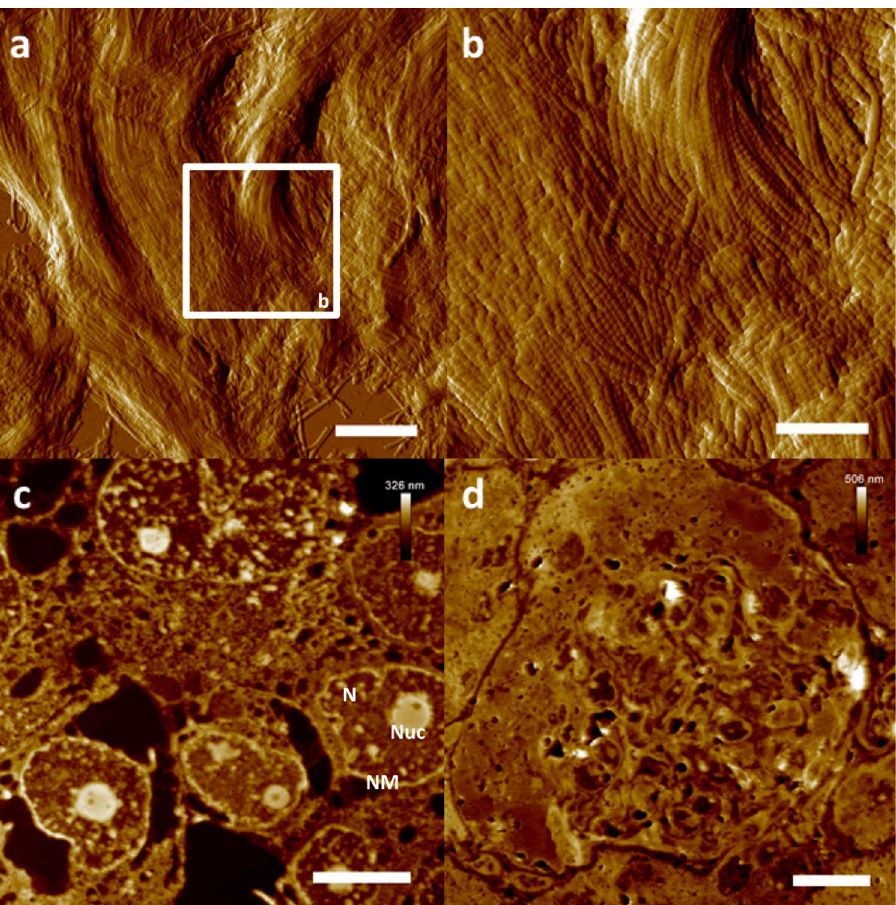
Figure 3. AFM-based ultrastructural analysis of exemplary mammalian tissues. Nanoscopic resolution on more complex tissues. ( a ) AFM amplitude data of an ultra-section of human knee cartilage. ( b ) High resolution close up on single collagen fibrils. Note the preservation as well as the clear resolution of the characteristic 67 nm D-periodicity of single collagen fibrils. ( c ) Height data depiction of an ultra-section from human melanoma tissue. ( d ) AFM height data of a mouse kidney ultra-section showing a single glomerulus as well as surrounding tubuli. Scale bars ( a ) 2 µm, ( b ) 840 nm, ( c ) 6 µm, ( d ) 10 µm. N nucleus, NM nuclear membrane, Nuc